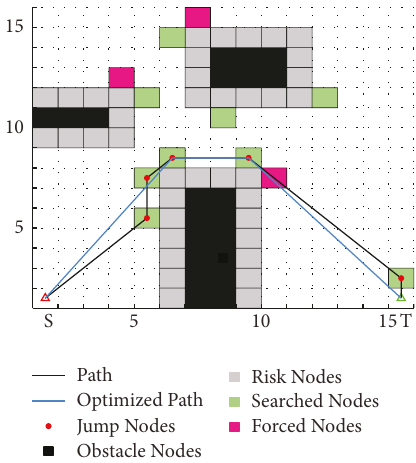
Figure 7: Redundant hop removal policy.